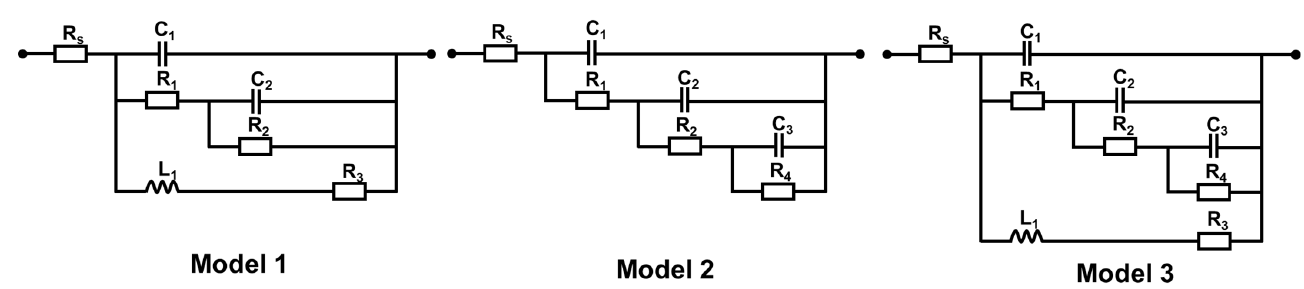
Table 1. When the frequency is equal to zero, the difference between the solution resistance and the actual impedance of the Nyquist plot is known as polarization resistance (Rp) [42]. Using this formulation as a guide, we can determine the equation for the equivalent Rp model as follows: resistance. For example, an Rp value of the Ce(IV)/PEI-C/PAA-GO sample increased to 3.5 × 10 4 Ω ·cm 2 at 48 h. Even after 72 h, it was able to maintain its excellent performance. In contrast, for the other coatings, at different periods, the R p values were reduced to min- imal values, indicating that the coating was cracked or had even peeled off at this point.